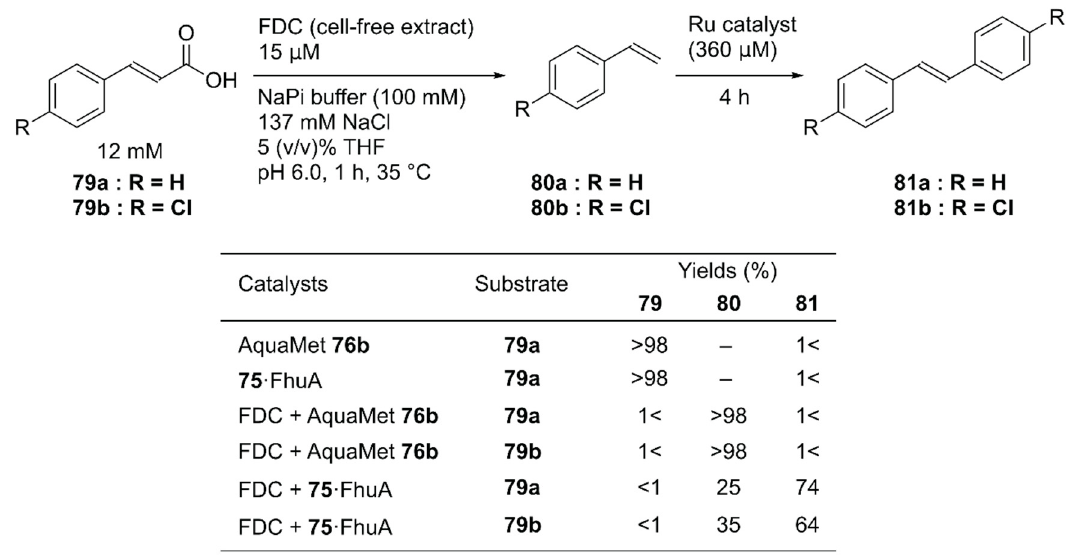
Figure 16. Sequential one-pot decarboxylation and olefin metathesis catalyzed by an FDC enzyme and a GH catalyst. Adapted from [112]. See Figure 15 for the structure of FhuA. Molecules 2020 , 25 , x